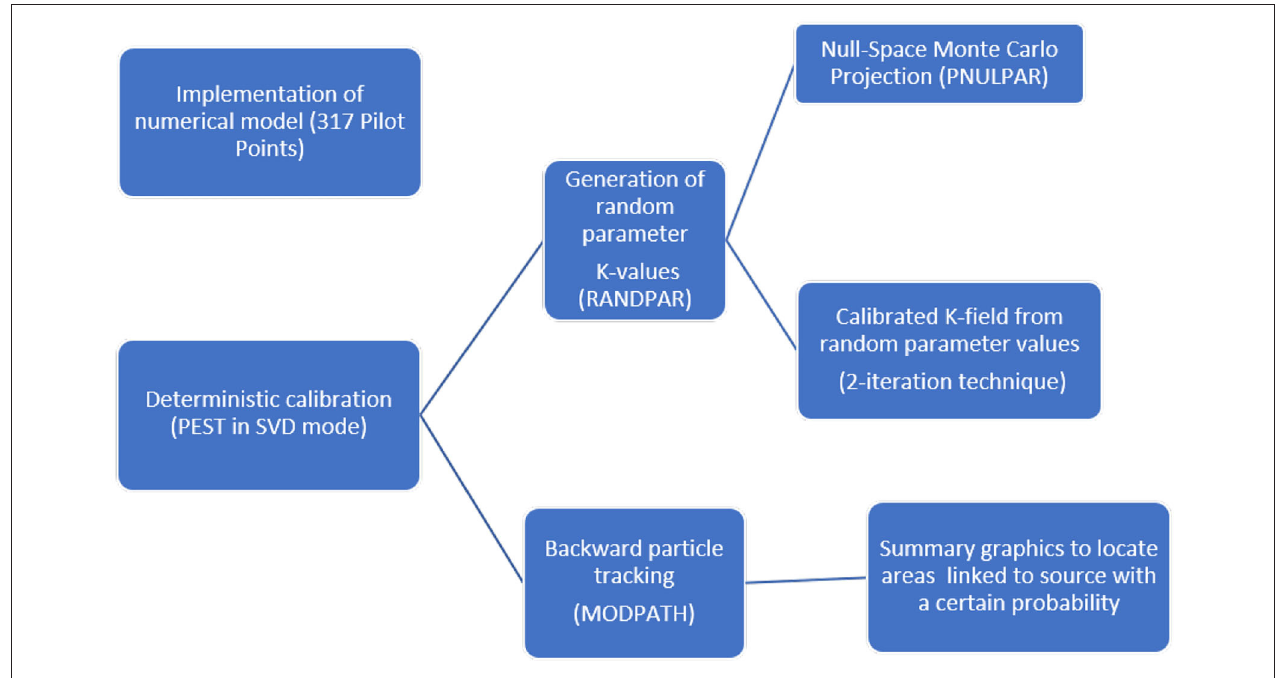
FIGURE 3 | Conceptual flowchart for the PT+NSMC